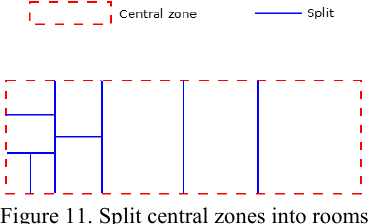
Figure 11. Split central zones into rooms